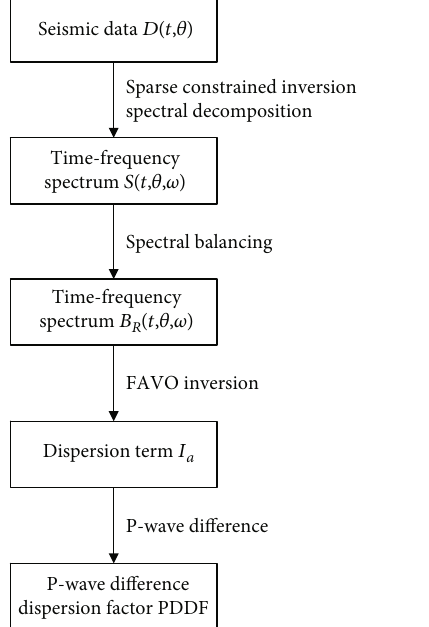
Figure 10: The prediction process of dispersion term and P-wave di ff erence dispersion